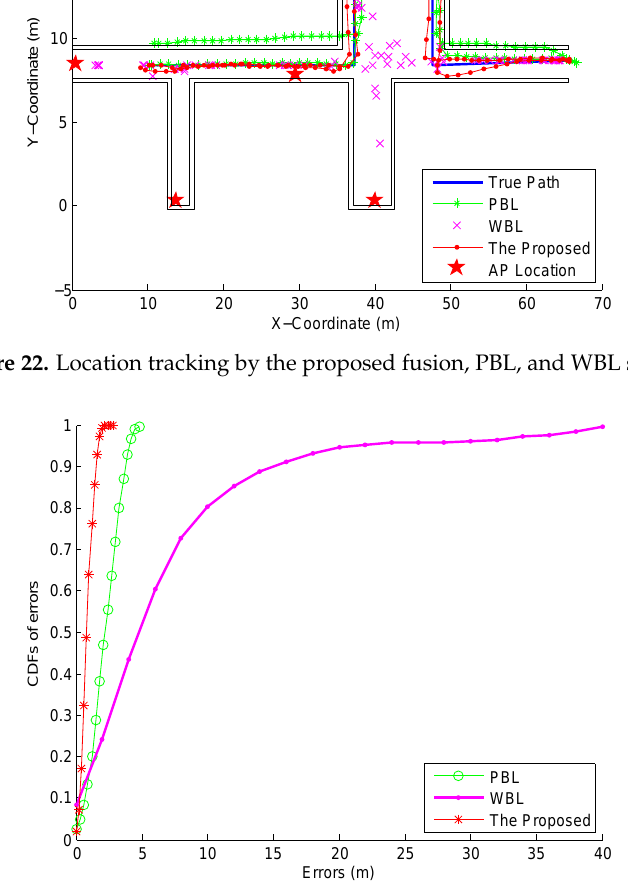
Figure 23. CDFs of errors by the proposed fusion, PBL, and WBL systems.